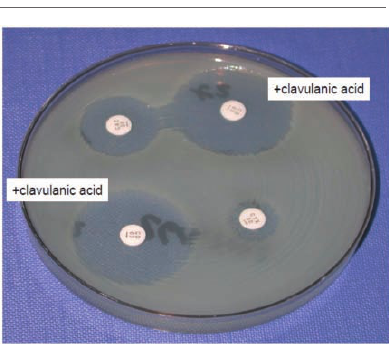
Figure 3. Combined Disk assay for detec- tion of extended spectrum beta lactamase. CTX, Cefotaxime; CAZ, Ceftazidime; CV, clavulanic